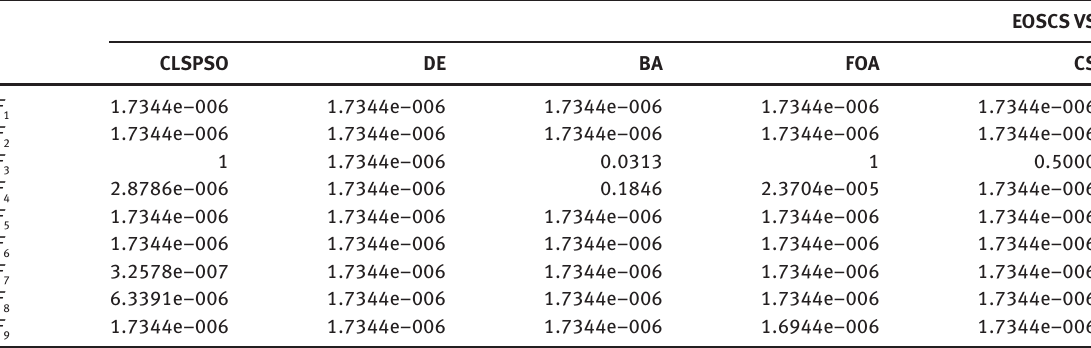
Table 9: p -Values Produced by Wilcoxon’s Test Comparing EOSCS versus CLSPSO, EOSCS versus DE, EOSCS versus BA, EOSCS versus FOA, and EOSCS versus CS Over The “Average Best-So-Far” Values from Table 1. EOSCS VS DE BA FOA